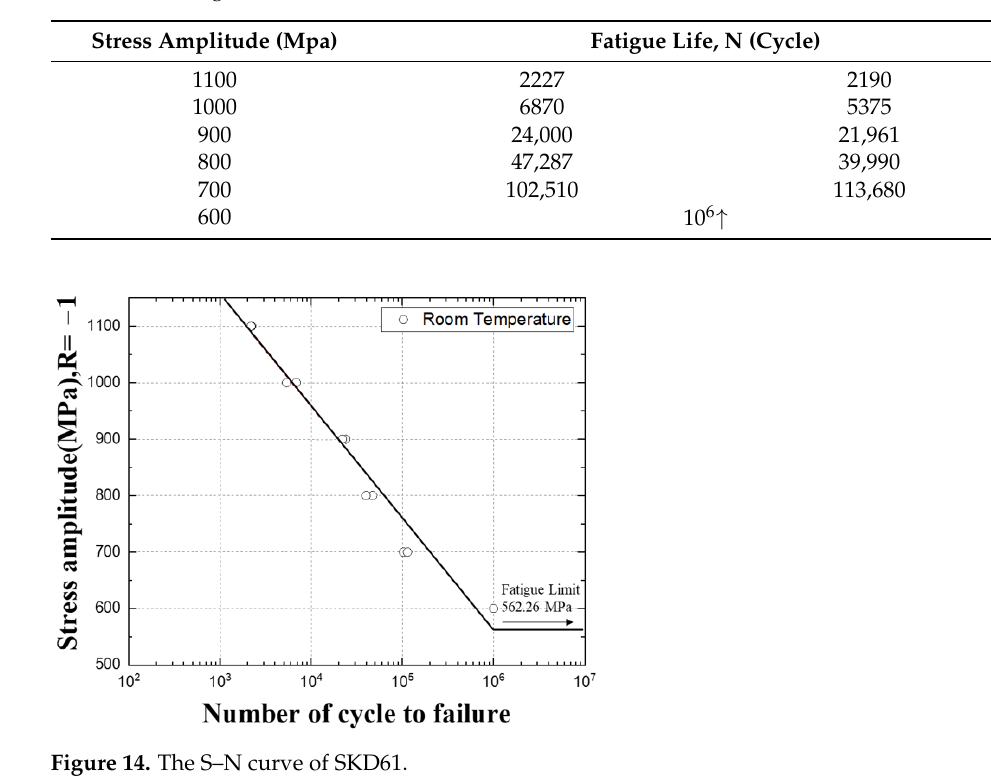
Table 5. The fatigue test result of SKD61.